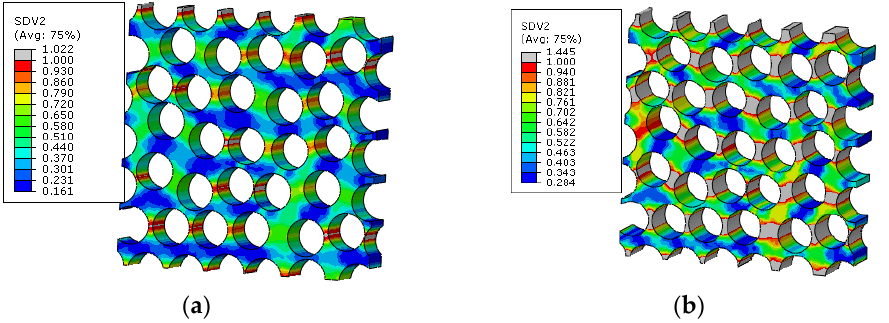
Figure 34. Failure indices and stress states in the matrix of fiber random distribution model. ( a ) failure indices; ( b ) equivalent stress; ( c ) first stress invariant.